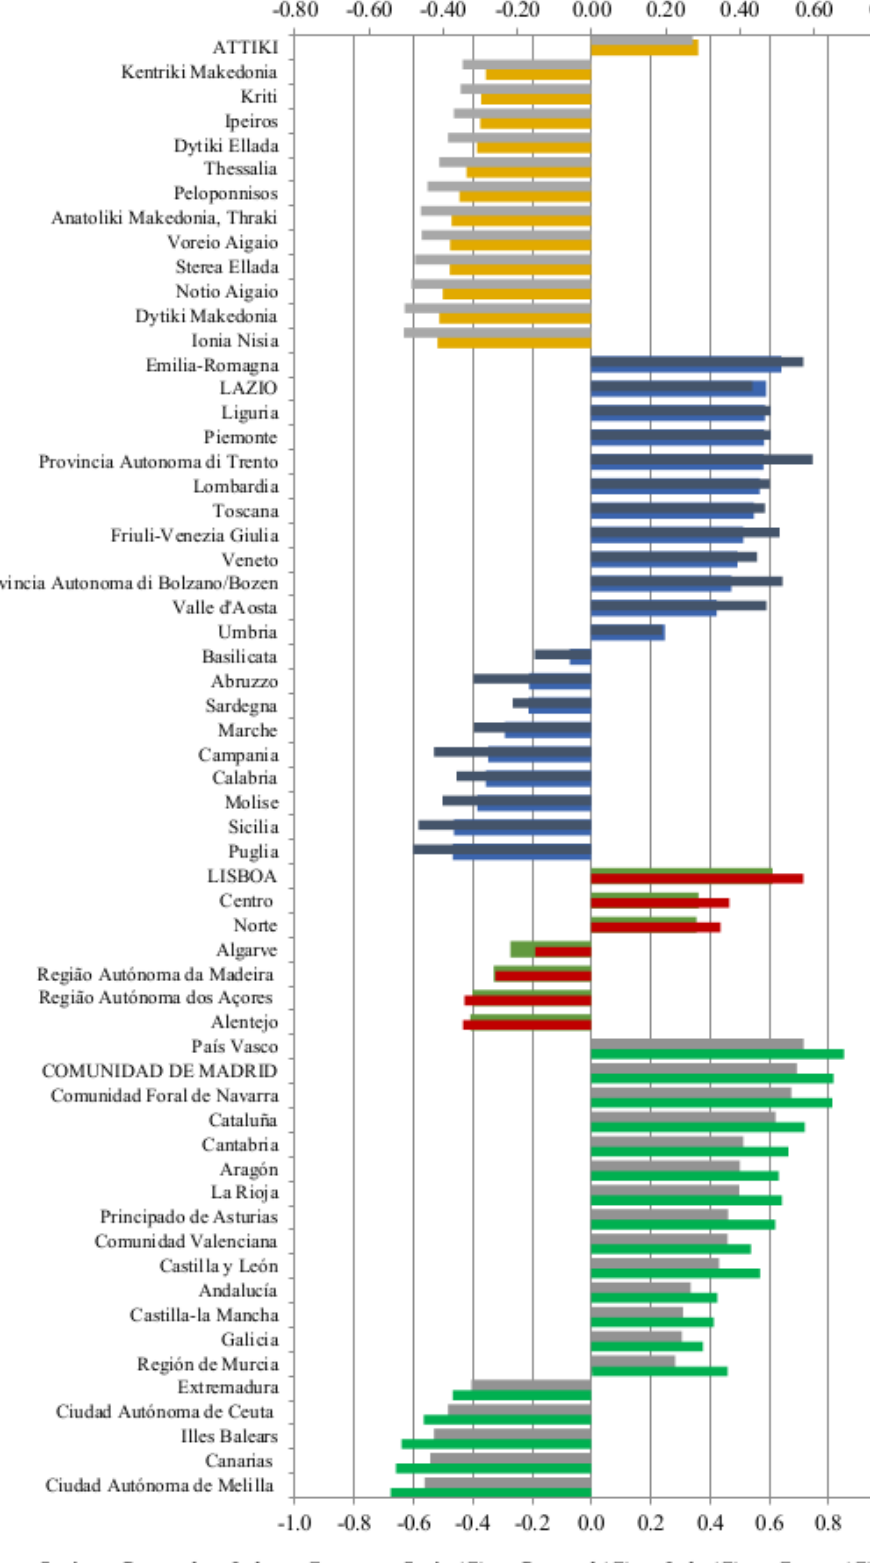
REGION : Volume 3, Number 2,